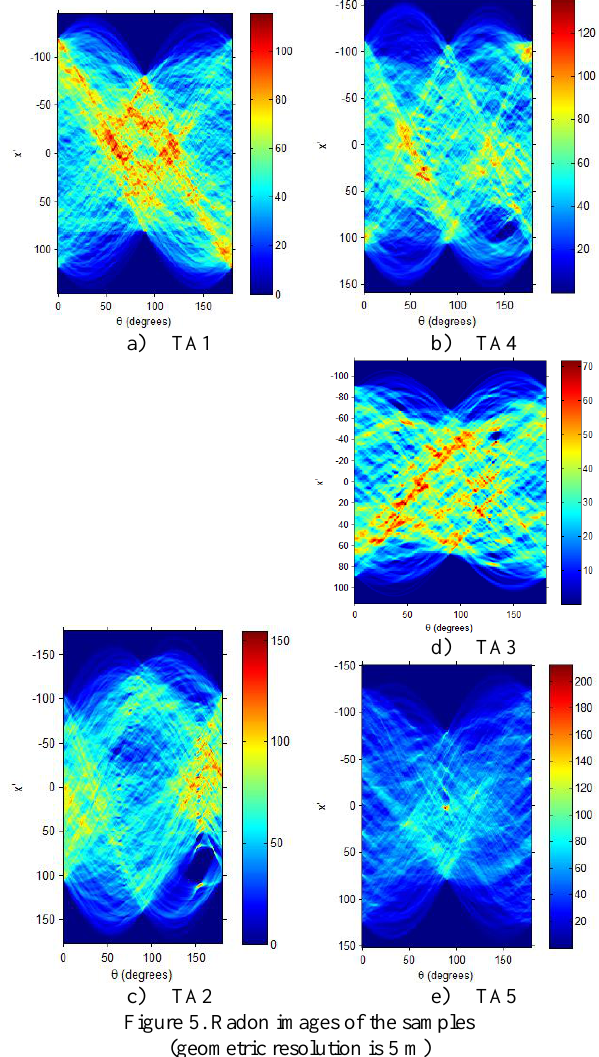
Figure 5. Radon images of the samples (geometric resolution is 5 m)